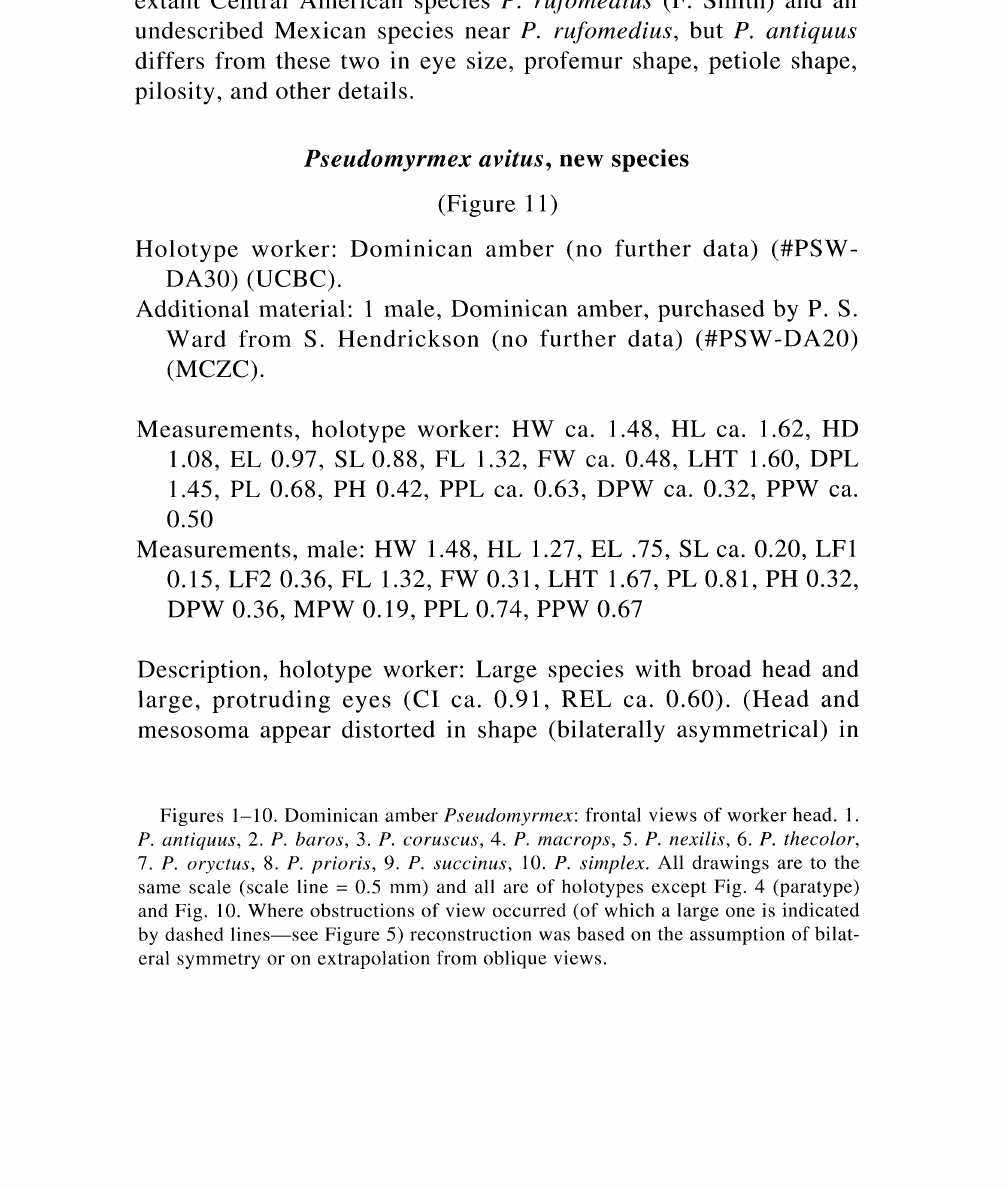
Holotype worker: Dominican amber (no further data) (#PSW- DA30)